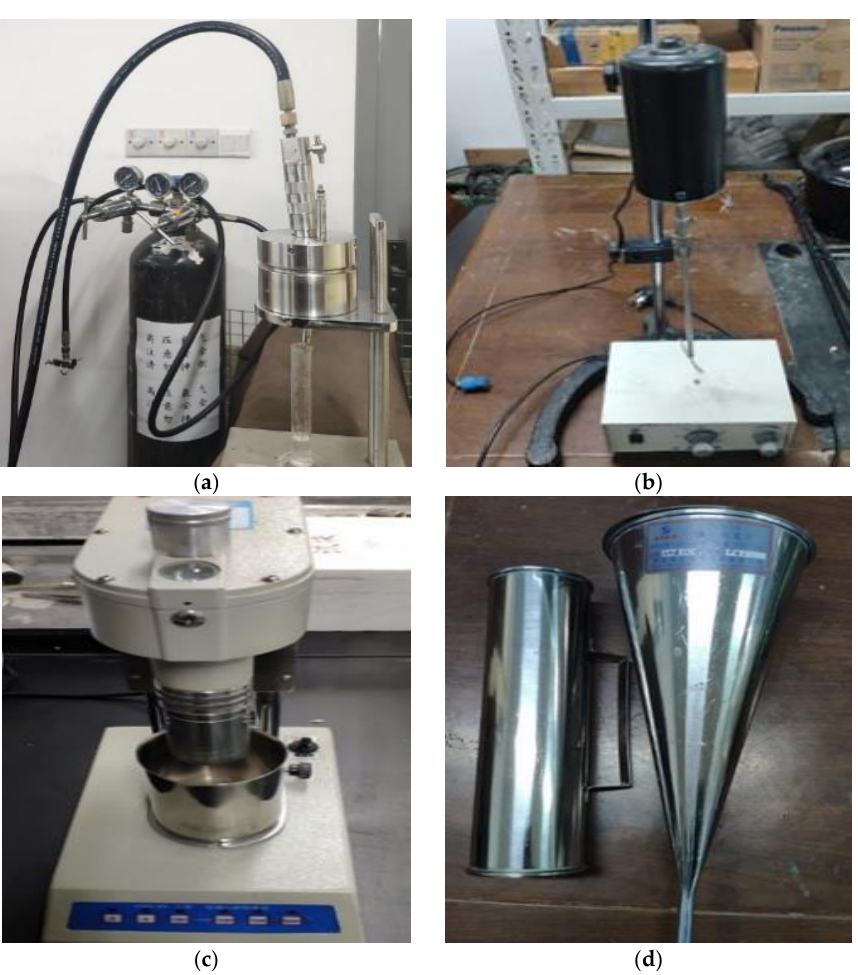
Figure 13. The experimental equipment of lubricating mud: ( a ) adhesion coefficient instrument, ( b ) electric agitator; ( c ) rotational viscometer; ( d ) funnel viscometer.